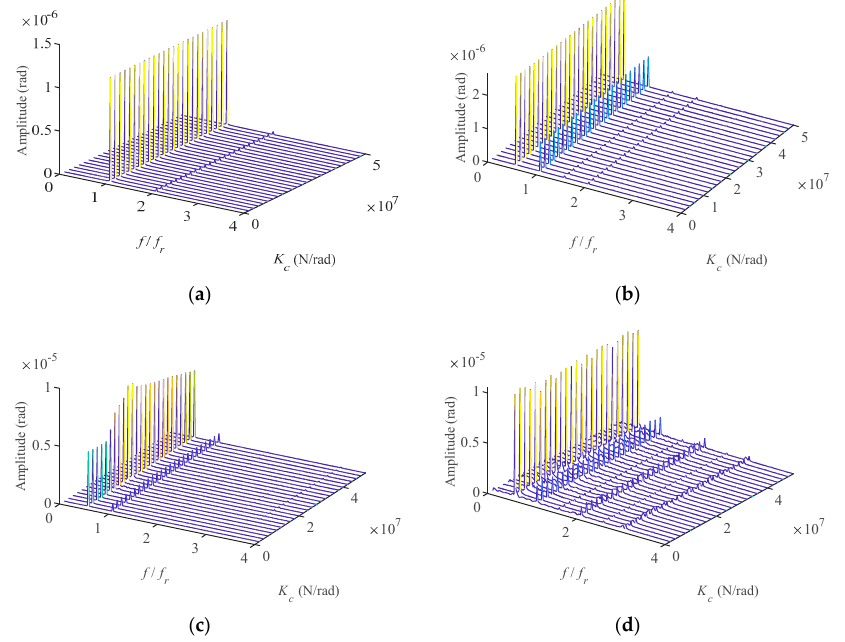
Figure 9. Waterfall diagram of vibration response varying with K c at different speeds: ( a ) ω = 500 rad/s; ( b ) ω = 800 rad/s; ( c ) ω = 1100 rad/s; ( d ) ω = 1800 rad/s.